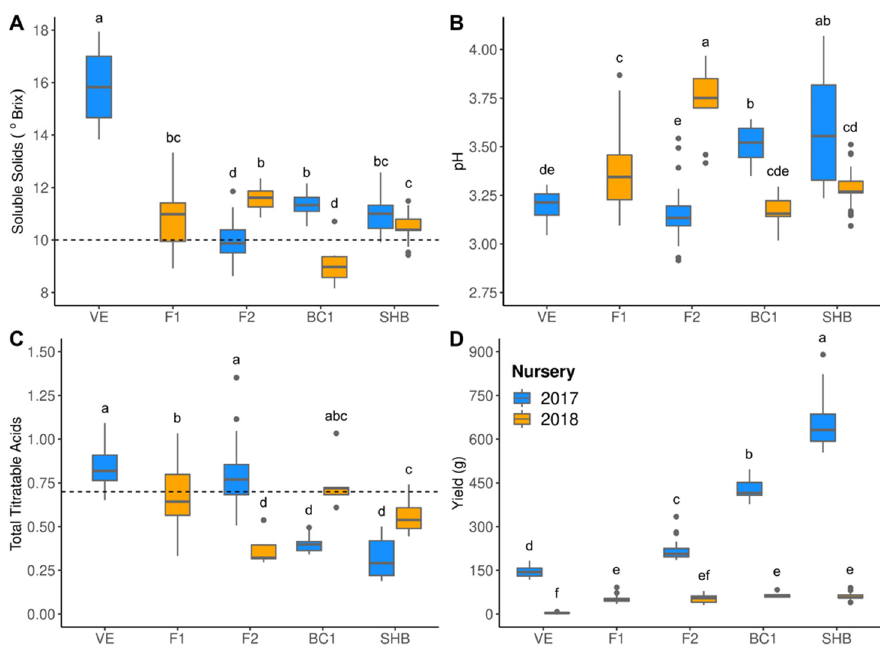
Figure 3. Soluble solids, pH, total titratable acids, and yield observed for five stages of blueberry breeding. Fruit quality-related traits evaluated in five stages of blueberry breeding: V. elliottii (VE), F 1 , F 2 , BC 1 , and Southern highbush (SHB) families. ( A ) Breeding values obtained for soluble solids, ( B ) breeding values obtained for pH, ( C ) breeding values obtained for fruit total titratable acids (TTA), and ( D ) breeding values obtained for yield. Note the difference of other traits, with TTA being below the target dotted line. Treatments with the same letters are not statistically different at alpha = 0.05.